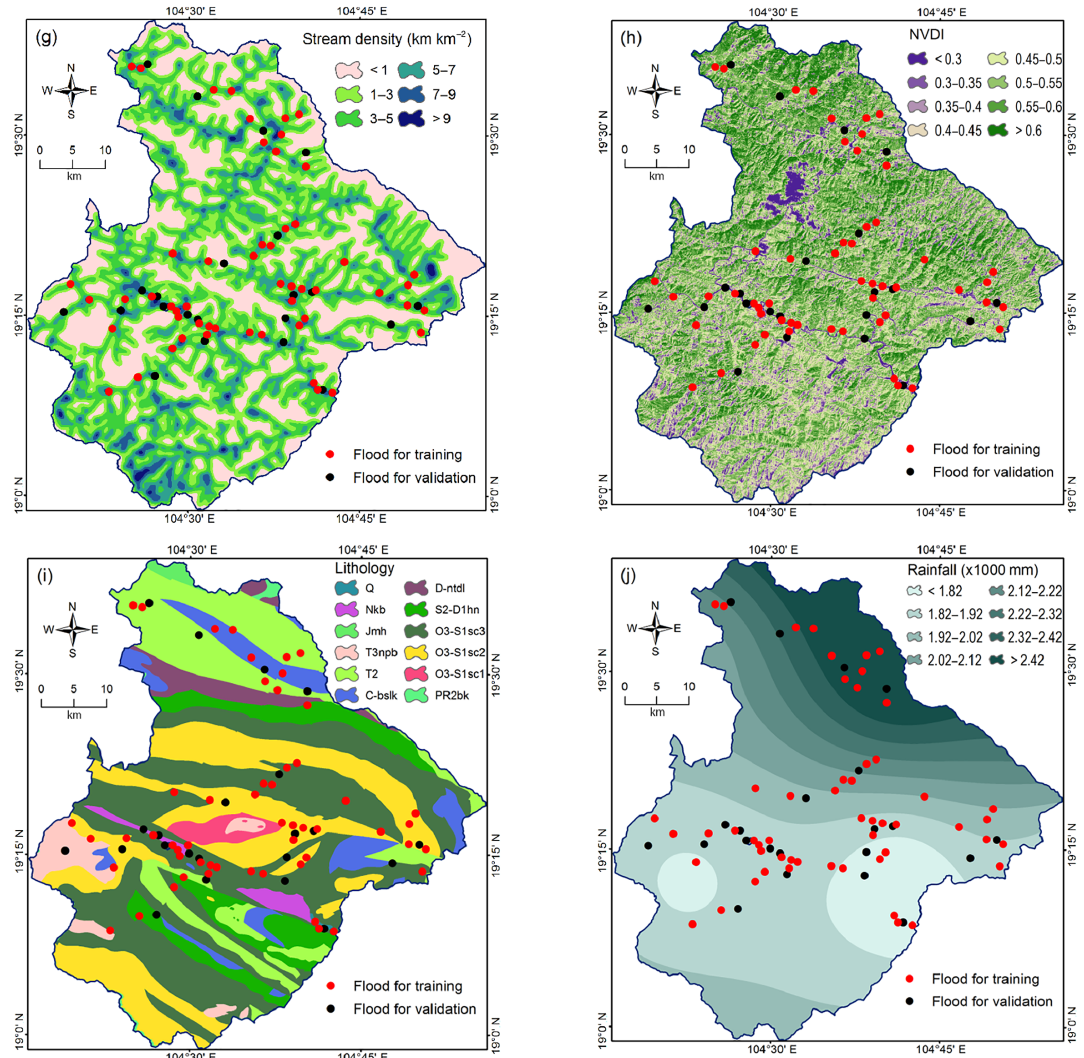
Figure 2. Flood-influencing factors: (a) slope, (b) elevation, (c) curvature, (d) topographic wetness index, (e) stream power index, (f) distance to river, (g) stream density, (h) normalized difference vegetation index, (i) lithology, and (j)